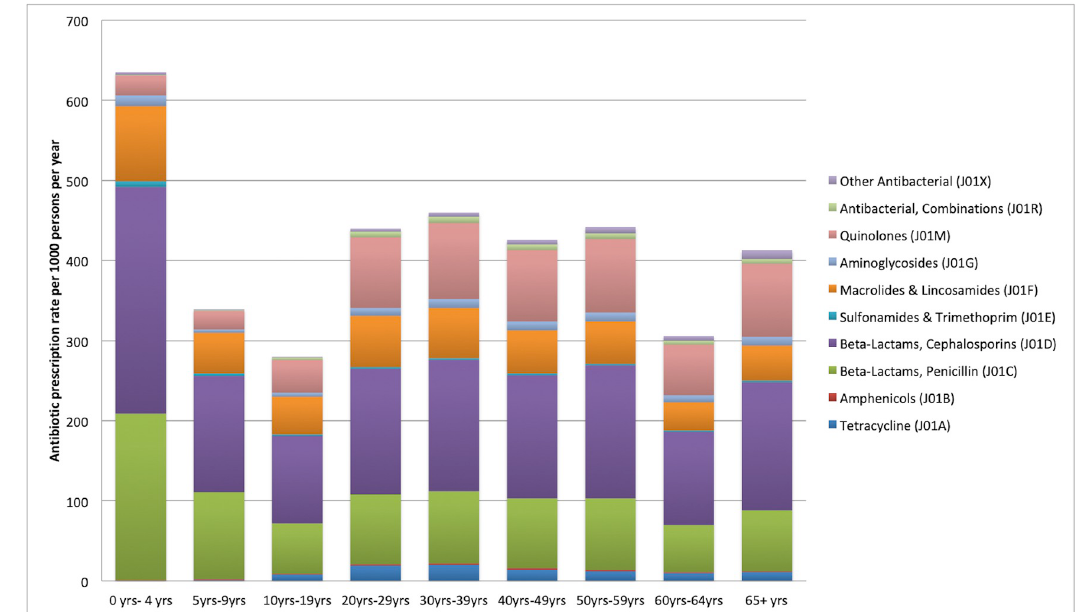
Fig 1. Outpatient antibiotic prescription rate per 1000 persons per year, by age groups and antibiotic classes, India (2013– 2014).